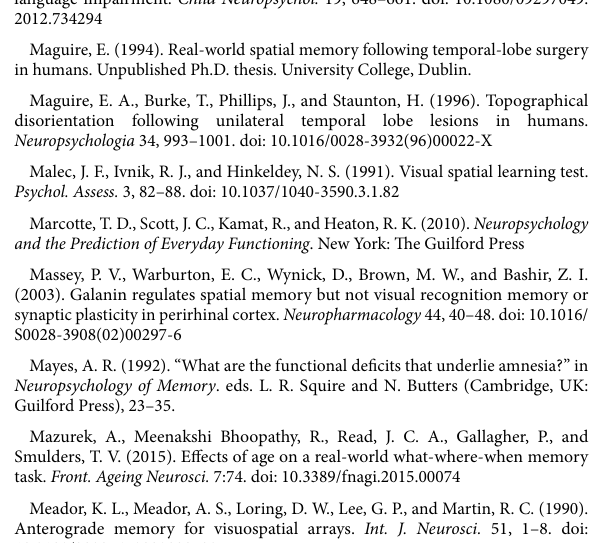
Complex Figure Usage: Clinical and Research Application . ed. J. A. Knight (Lutz, Fla: